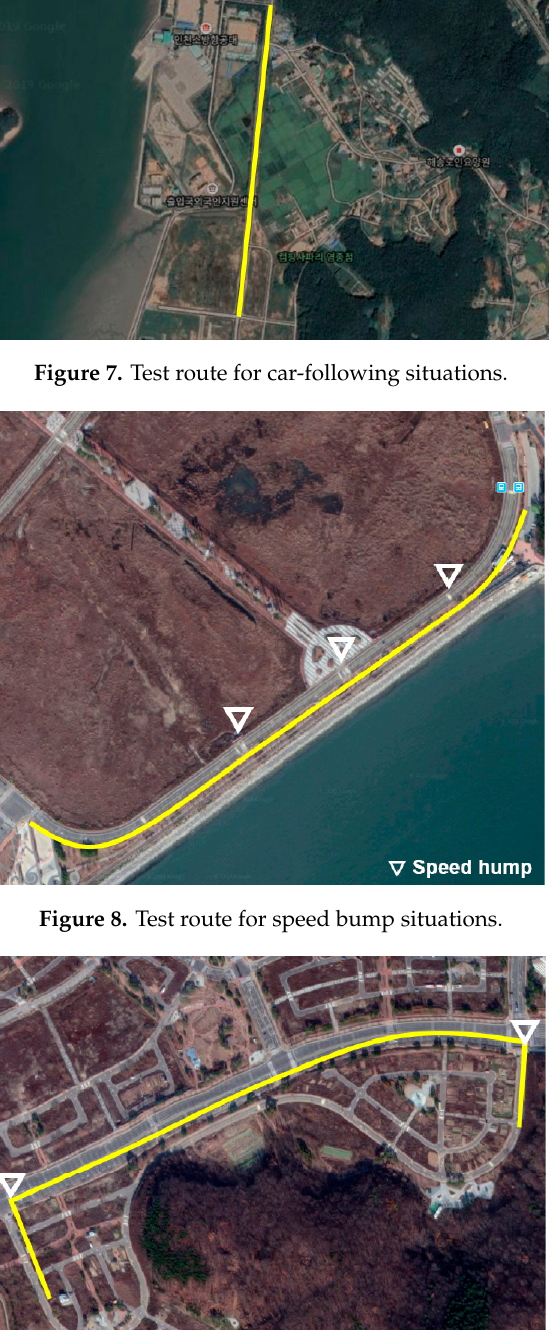
Figure 9. Test route for intersection situations.